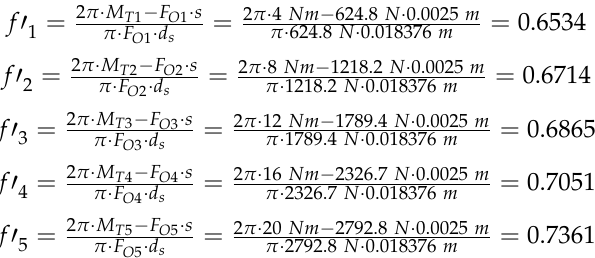
O on time from the EMS Center